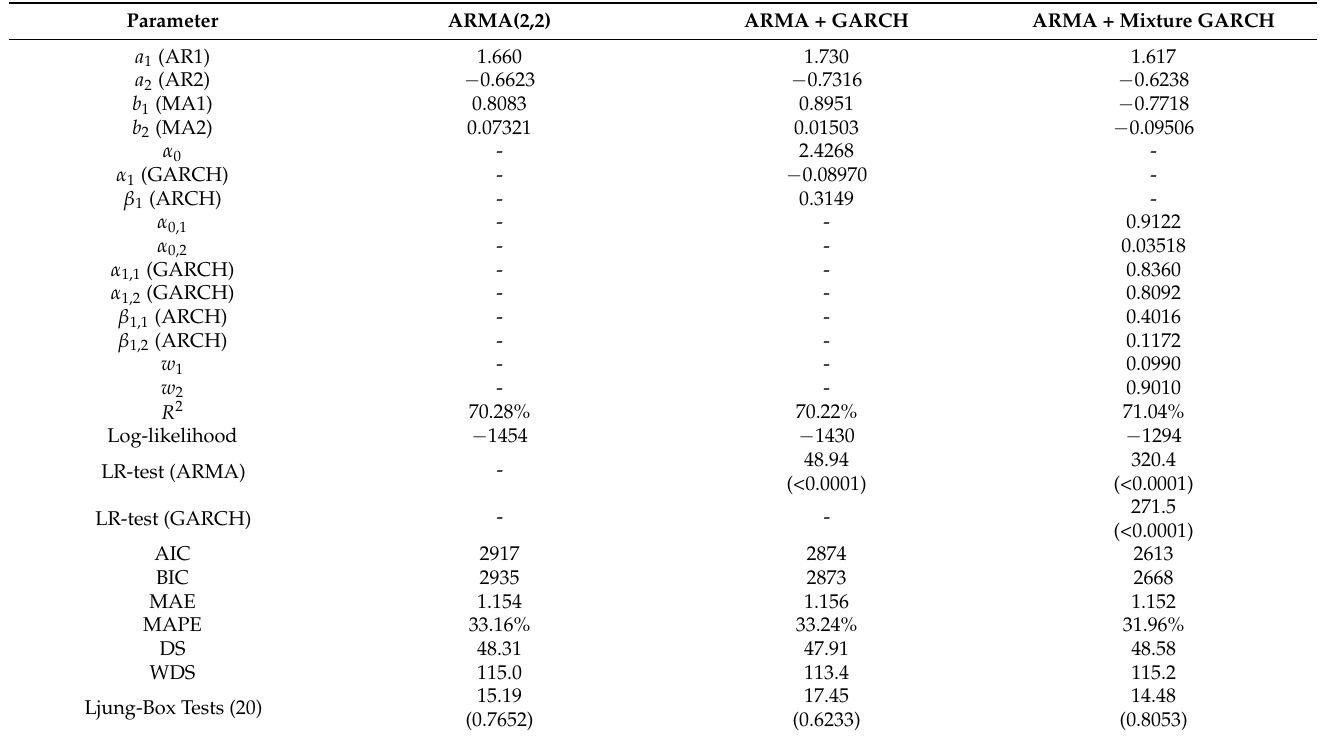
Table 2. Estimated parameters and performance measures for the second wind speed data